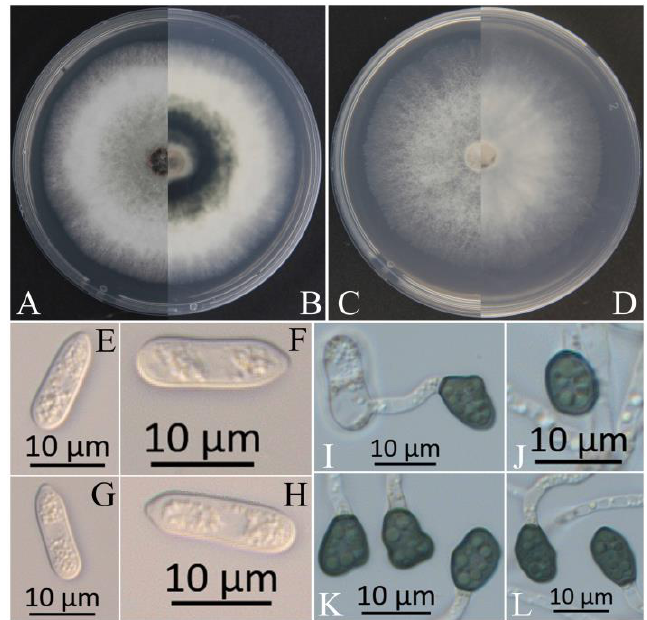
Figure 5. Morphological characteristics of XZEC41. ( A , B ) Front and reverse views of 4-day-old fungus on PDA, respectively. ( C , D ) Front and reverse views of 4-day-old fungus on SNA, respectively. ( E – H ) Conidia. ( I – L ) Appressoria. Scale bars: ( E – L ) = 10 μm.